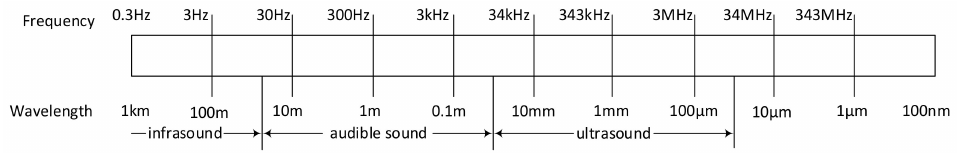
Figure 3. Acoustic frequencies and